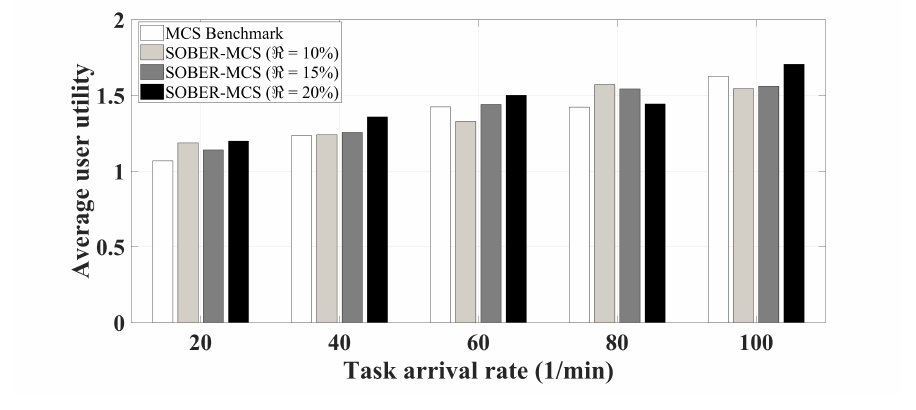
Figure 10. Average user